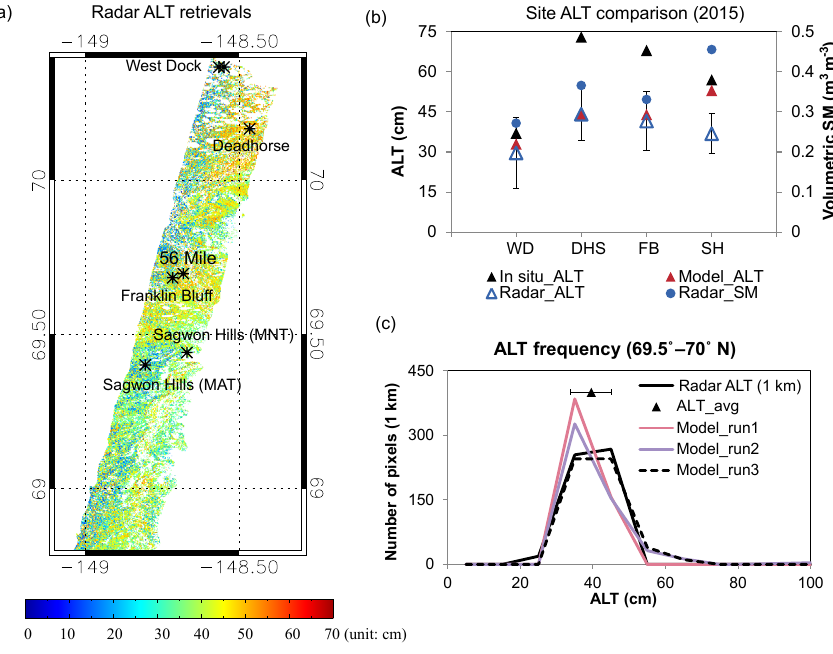
Figure 4. Comparison of radar ALT retrievals with in situ CALM site observations and model simulations within the Alaska Dalton Highway (DH) sub-region defined from the airborne radar (AirMOSS, UAVSAR) flight transect in October 2015: (a) the radar-retrieved ALT map from the combined (P + L-band) low-frequency radar backscatter measurements, with areas indicated as open water, perennial ice/snow, and developed areas masked out; (b) comparisons of the in situ ALT observations, radar retrievals, and model simulations at the CALM sites, including West Dock (WD), Deadhorse (DHS), Franklin Bluff (FB), and Sagwon Hills MNT (SH); and (c) comparisons of the ALT spatial distributions derived from the radar retrievals and model simulations for the DH latitudinal zone between 69.5 and 70 ◦ N. Different model runs were driven using different regional drivers (Table 3). ALT_avg is the regional mean of radar ALT retrievals, with error bars representing the standard